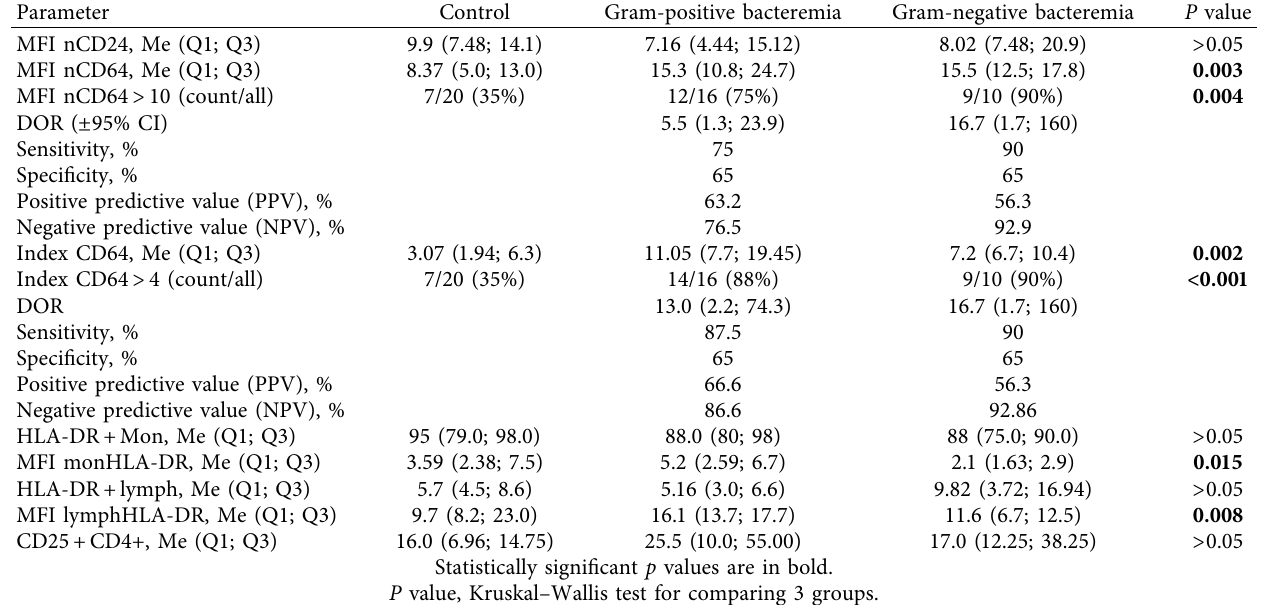
Table 4: Activation